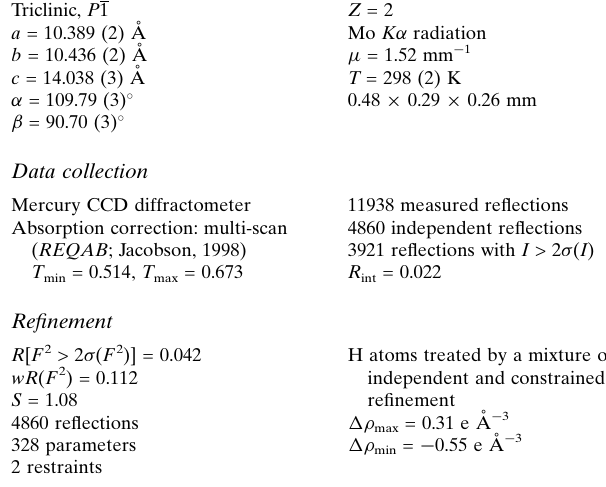
11938 measured reflections 4860 independent reflections 3921 reflections with I > 2 (cid:1) ( I ) R